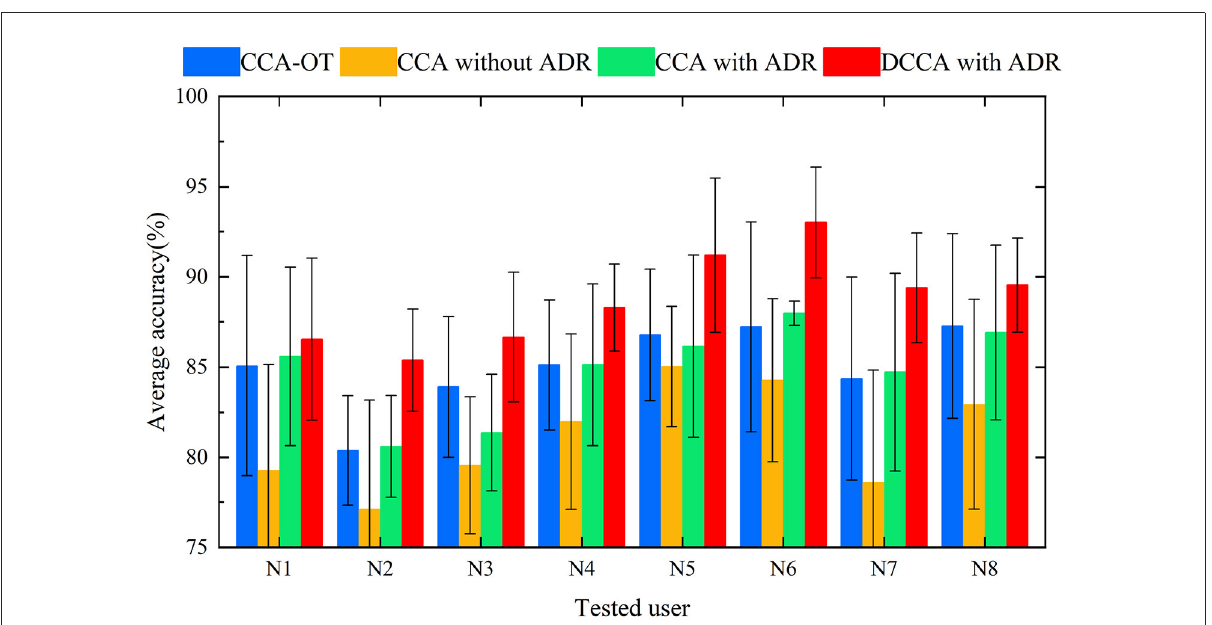
FIGURE6 Histogram of average accuracies of 12 campaigns classified by four methods for eight users (randomly reducing the user test set by two